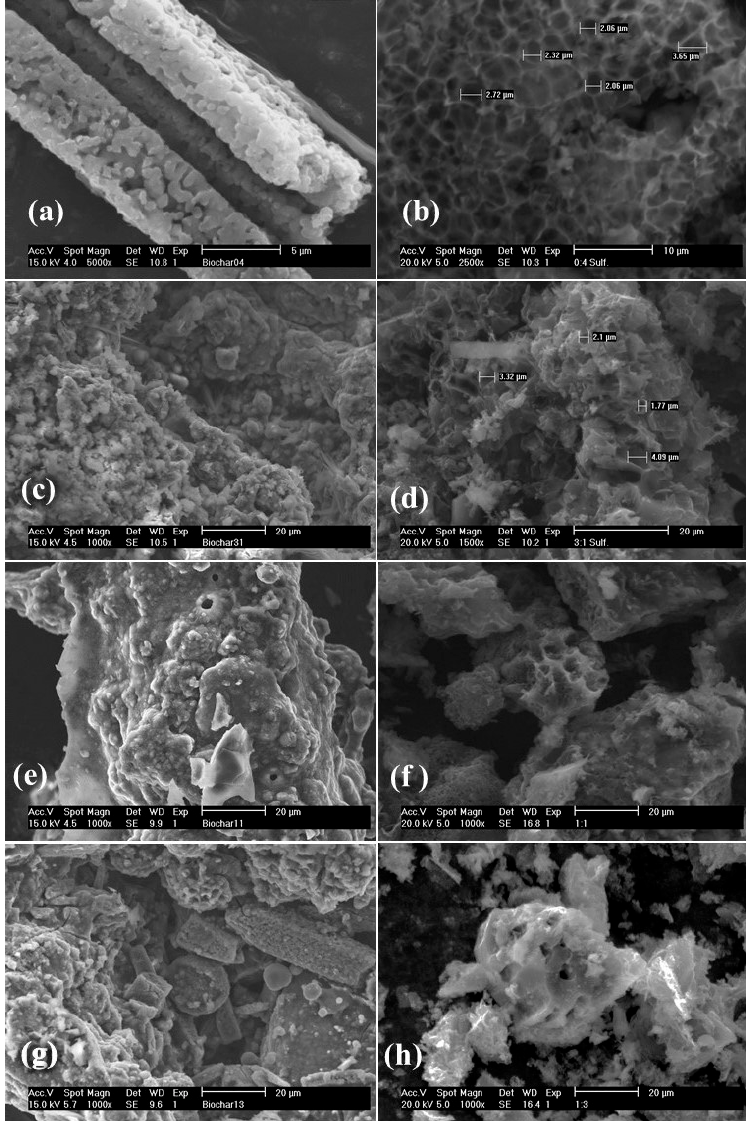
Figure 3. Micrographs of catalysts obtained at 800 °C: ( a ) B-100-8, ( b ) BS-100-8, ( c ) B-25-8, ( d ) BS-25-8, ( e ) B-50-8, ( f ) BS-50-8, ( g ) B-75-8, ( h ) BS-75-8.